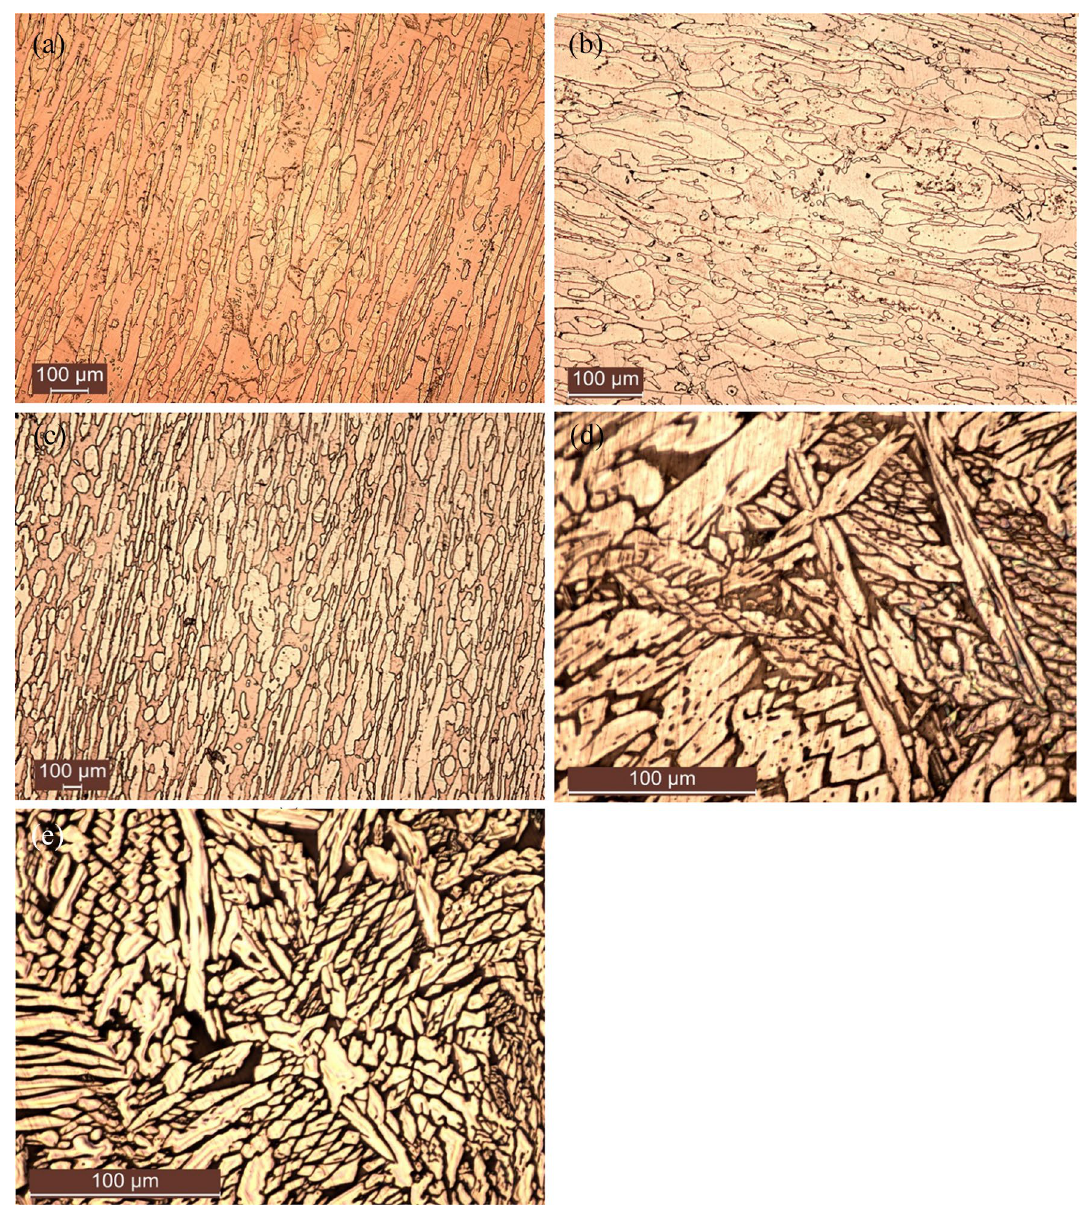
Fig. 1 Optical microscopy images of wrought and welded alloys: a 2003, b 2101, c 2205 d 2101-w, e 2209-w after 10,000 h of aging